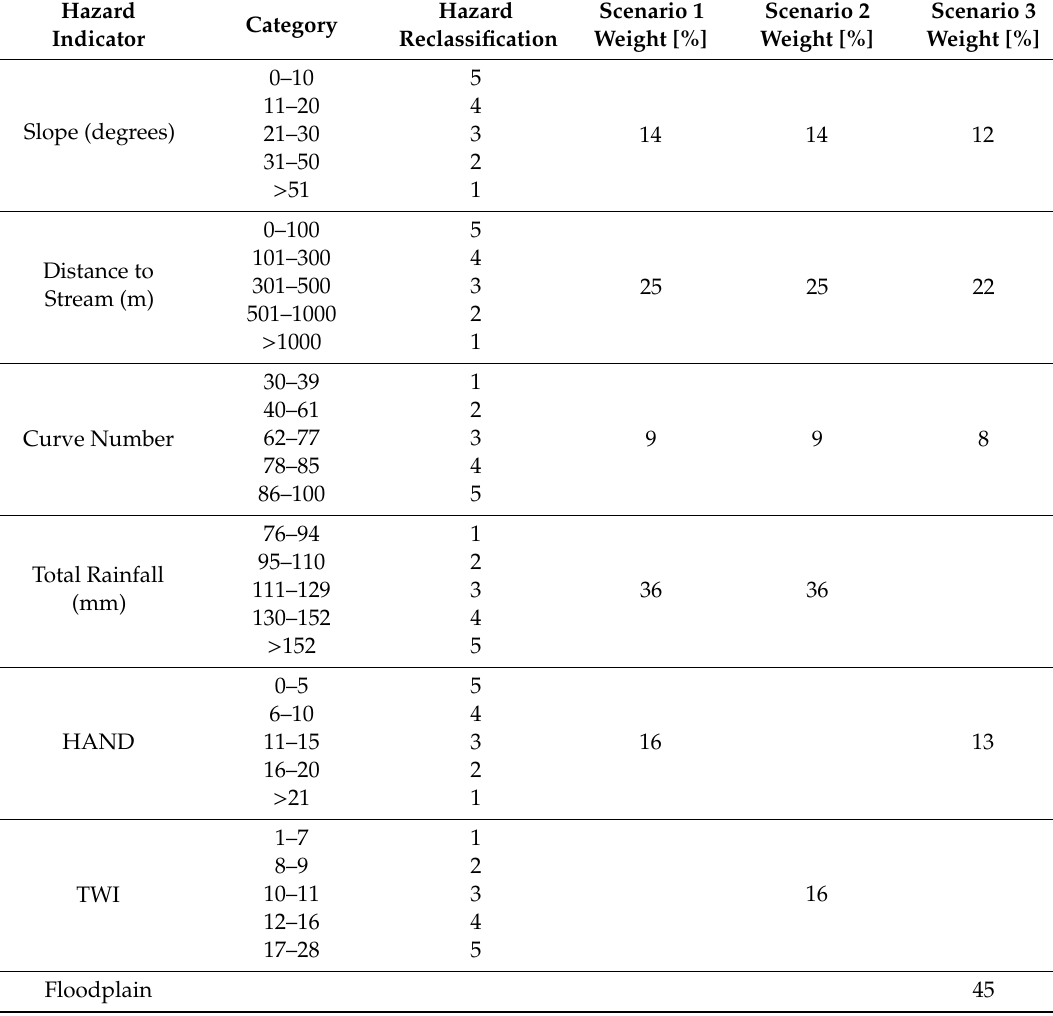
Table 1. Flood hazard indicators and weight.